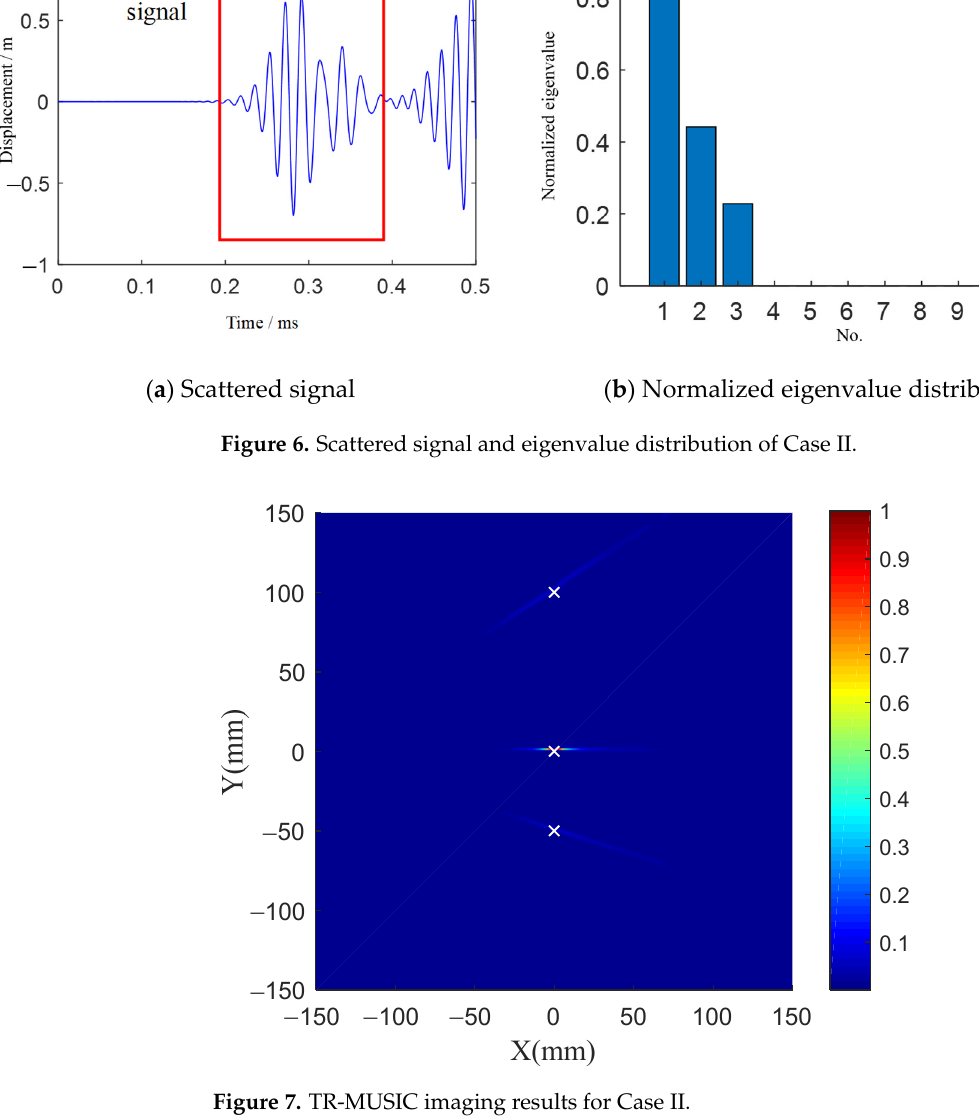
Figure 7. TR ‐ MUSIC imaging results for Case II.